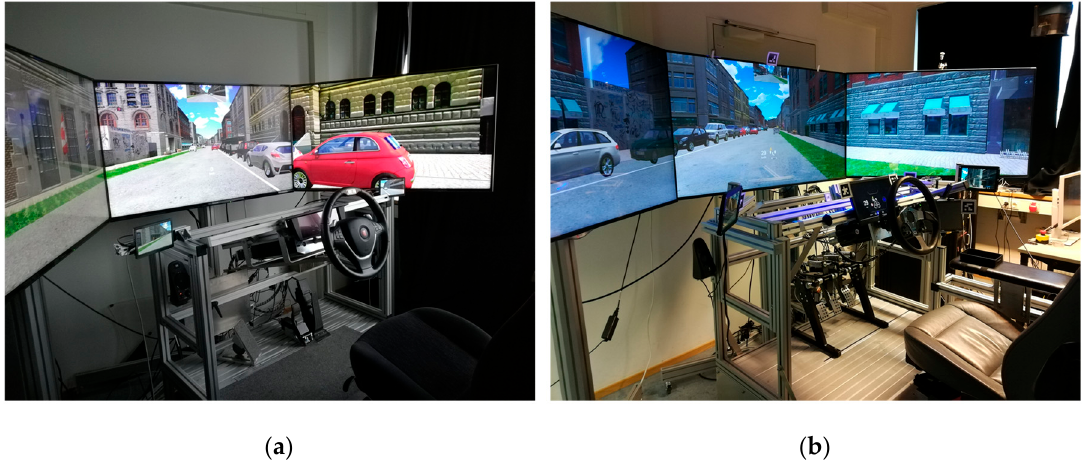
Figure 6 . Modular driving simulators. ( a ) Manual vehicle setup; ( b ) Automated vehicle setup with blue LED-strip .